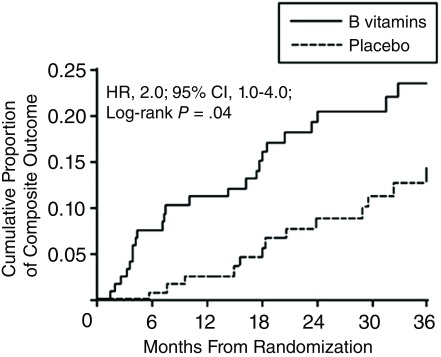
Cumulative proportion of myocardial infarction, stroke, revascularization, and all-cause mortality with high-dose B vitamins in patients with diabetic nephropathy.Diabetic nephropathy patients receiving folic acid 5 mg, B6 25 mg and B12 1,000 μg daily had twice the risk of events compared to patients receiving placebo. All of the events occurred in patients with a glomerular filtration rate of <50 mL/minute/1.73 m²
45. Reproduced by permission of the American Medical Association from
44.